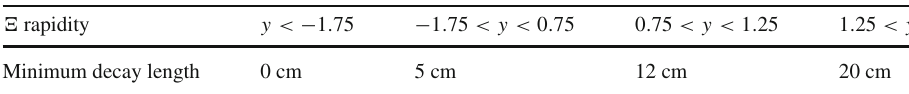
(cid:2) rapidity y < − 1 . 75 Minimum decay length 0